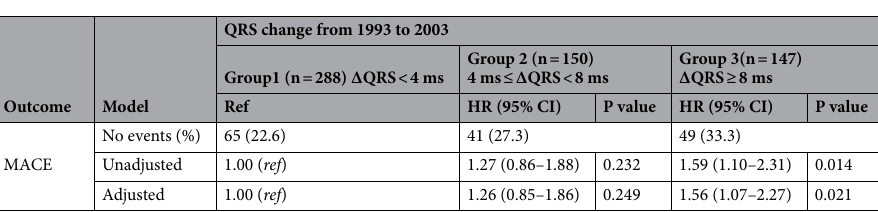
Table 2. Outcome data according to different ΔQRS group. Adjusted for: body mass index, systolic blood pressure, hyperlipidemia, diabetes and heart